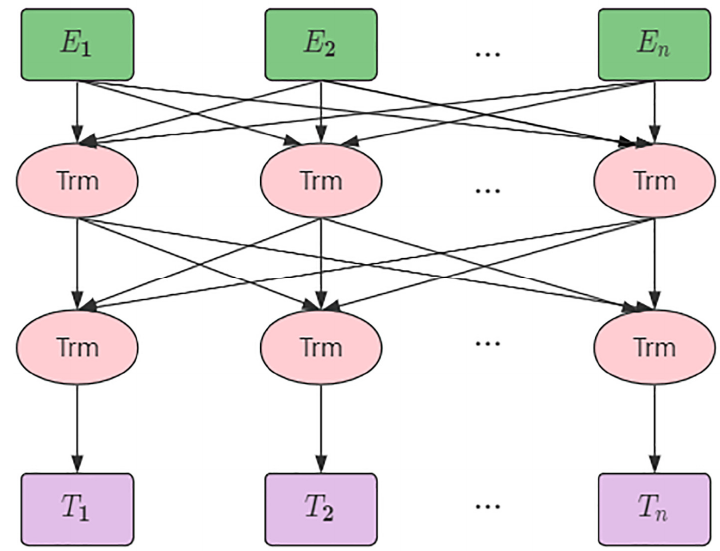
Figure 2. BERT Figure 2. BERT structure.